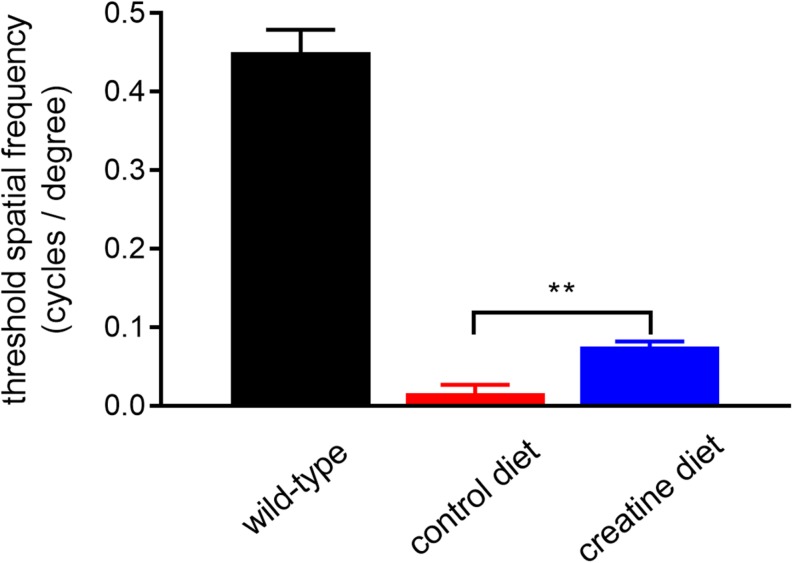
Performance of Rd1 mice in the optomotor tracking test undertaken at P30. Values represent mean ± SEM, where n = 18–21. ∗∗P < 0.01 by Student’s unpaired t-test (creatine-enriched diet vs. control diet eyes).